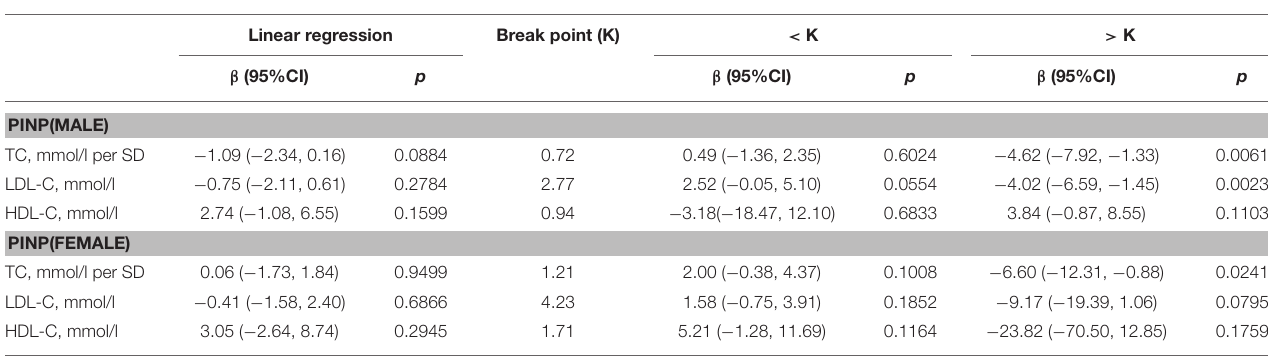
TABLE 6 | Multivariate Regression for Effect of TC, HDL-C, and LDL-C on PINP. Linear regression Break point (K) < K > K β (95%CI) p β (95%CI) p β